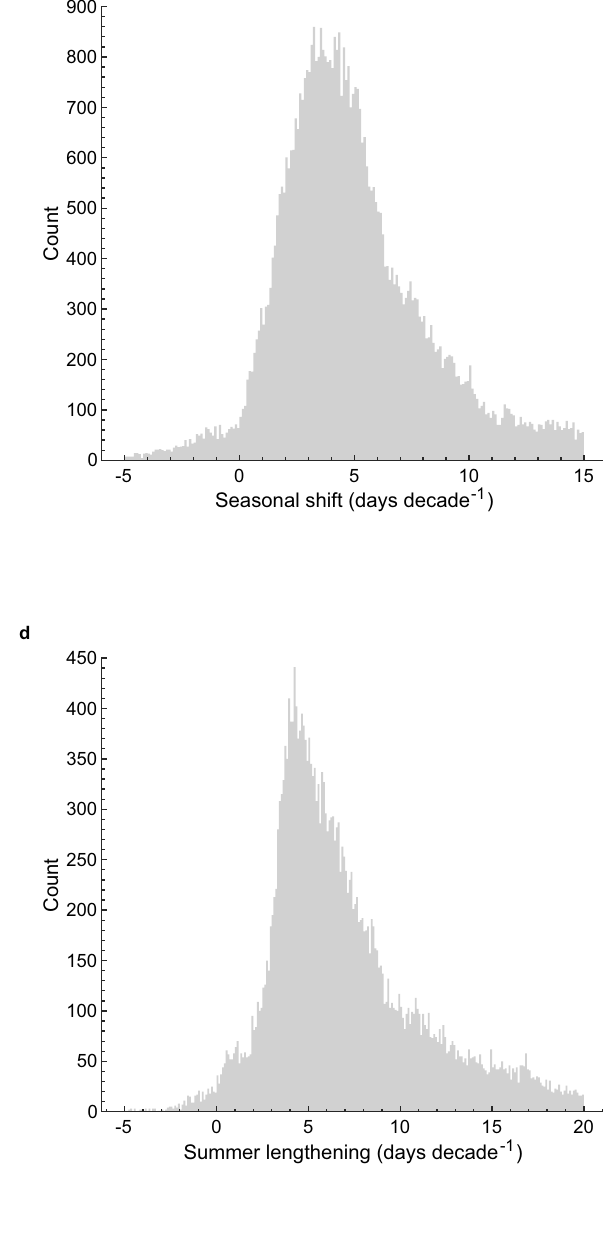
Fig. 2 | Alterations to the timing and duration of summer in lakes. Shown are ( a , b ) calculated shifts (days decade − 1 ) in the timing of summer (June – August) temperatures across Northern Hemisphere (NH) lakes during the historic to con- temporary period (1980 – 2021). Positive and negative values indicate when the timingofsummerhasadvancedorbeendelayed,respectively.ResultsforSouthern Hemisphere (SH) lakes are shown in Fig. S8. Also shown in panels ( c ) and ( d ) are calculatedchangestothedurationofsummer,estimatedasthedifferencebetween